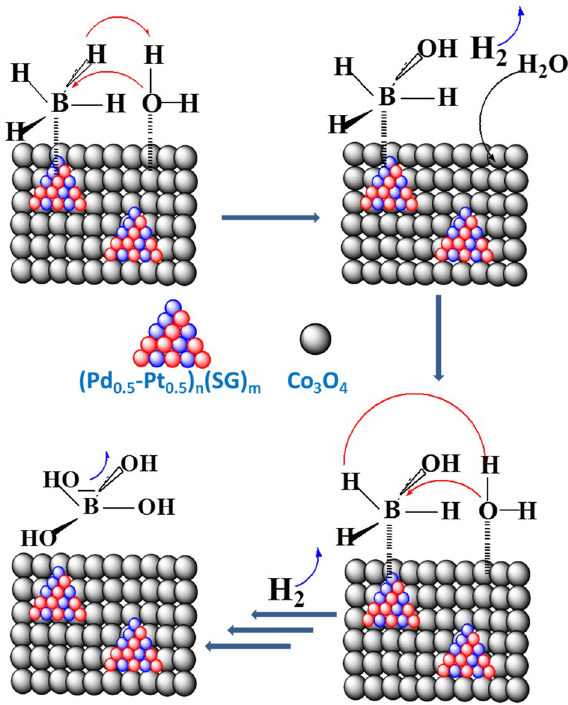
Figure 10. Suggested mechanism of NaBH 4 hydrolysis over (Pd 0.5 –Pt 0.5 ) n (SG) m /Co 3 O 4 catalyst, according to the Langmuir–Hinshelwood